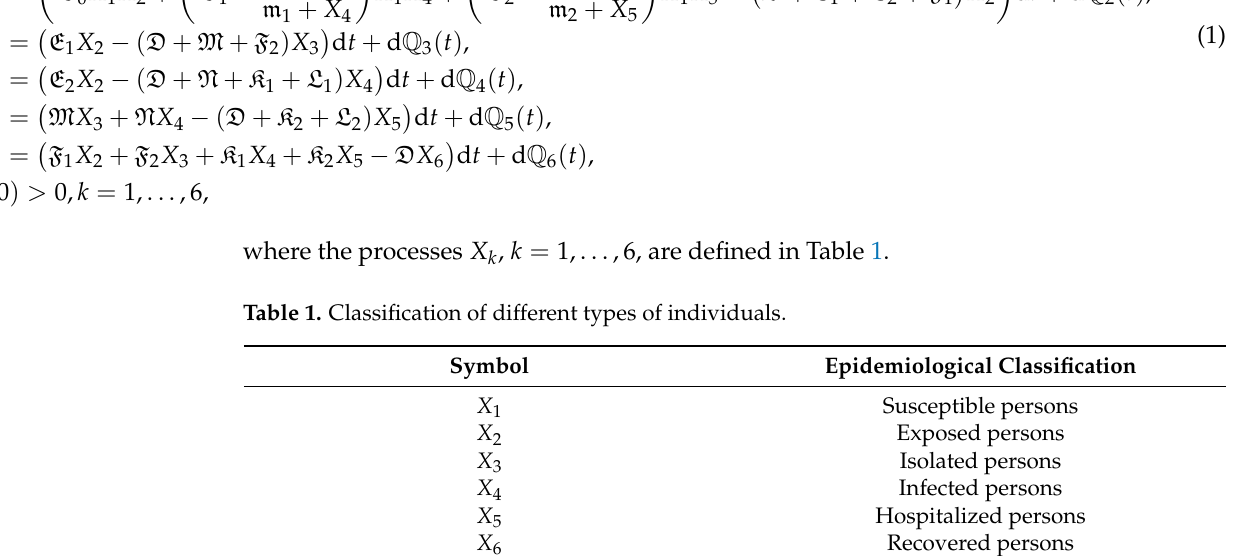
The cure rate of X 3